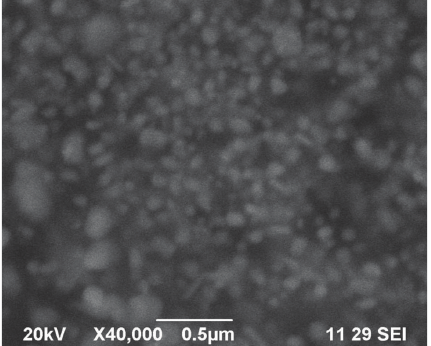
Figure 3: SEM images of silver nanoparticles synthesized from M. tinctoria leaf extract show highly agglomerated spherical shape.